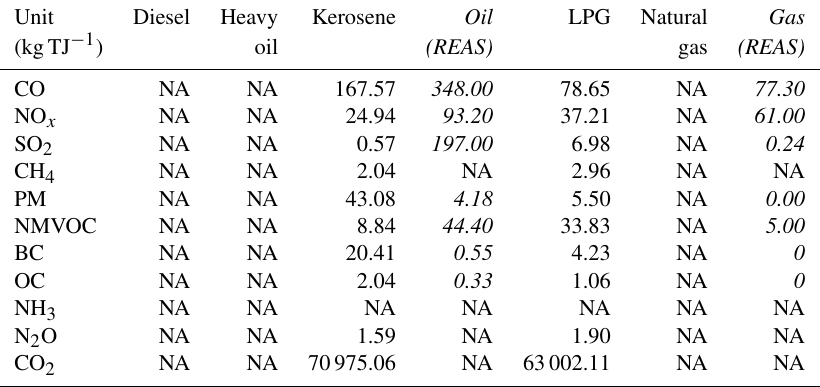
Table 17. Comparison of emission factors used for the domestic sector in this study and in REAS v2.1. Italic numbers refer to emission factors used in REAS 2.1.